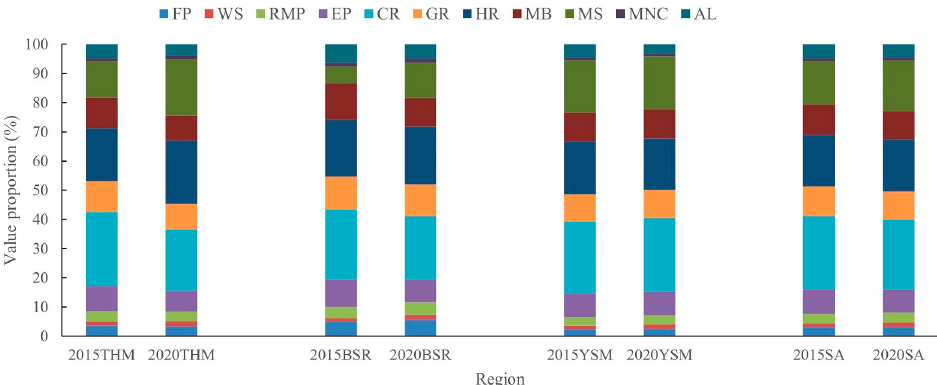
Figure 9. The value proportion of ecosystem service categories in the study area, THM, BSR and